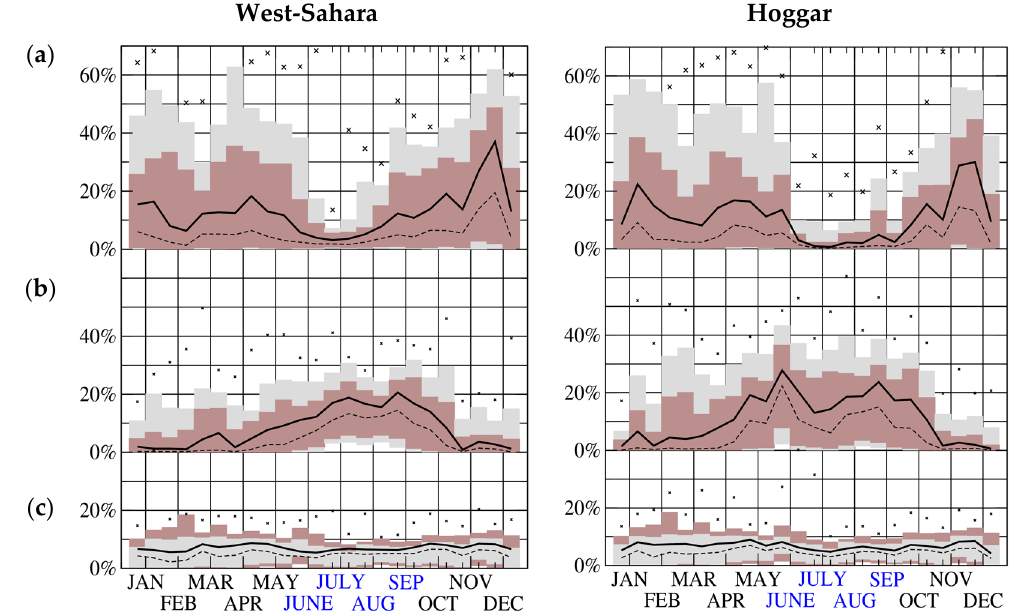
Figure 6. ( a ) annual cycle of the distributions of high-top daily cloud cover occurrence frequency (DCOF) distributions built over 15 day periods for West-Sahara (left) and Hoggar (right). ( b , c ) same as ( a ) but for mid-top DCOF and daily very-partial cloud cover occurrence frequency (VP DCOF), respectively. Each 15 day distribution has been partitioned in three parts, using the 5% percentile, 15% percentile, 85% percentile and 95% percentile. The brown areas span the part of the distribution within the 15th and 85th percentiles, the gray areas span the part of the distribution within the 5th and 95th percentiles. Dashed black lines indicate the 50th percentile, solid black lines indicate the 70th percentile, crosses indicate the maximum values.